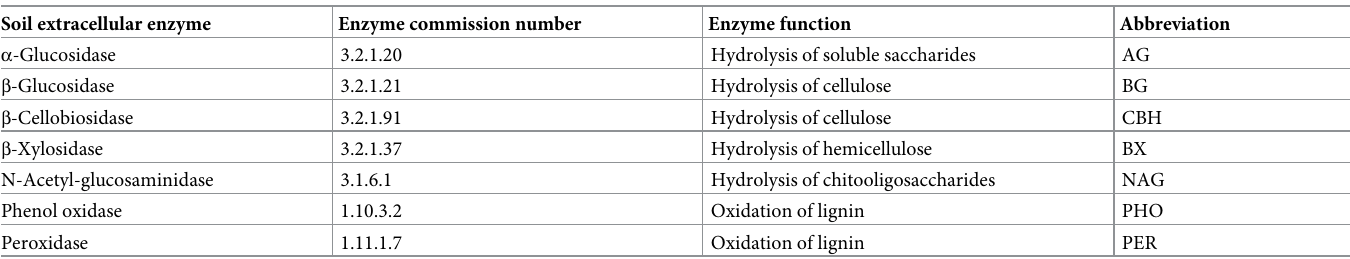
Table 3. A detailed description of soil extracellular enzymes in this